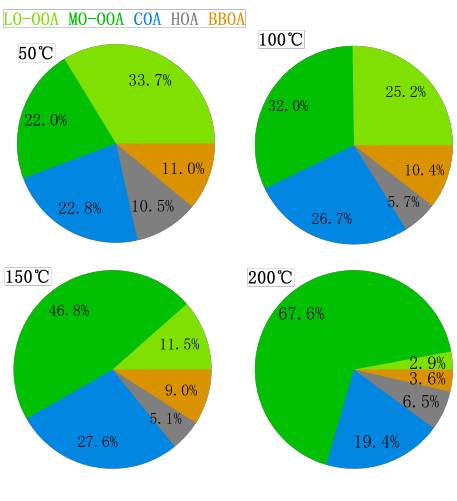
Figure 4. The average compositions of the total OA at different TD